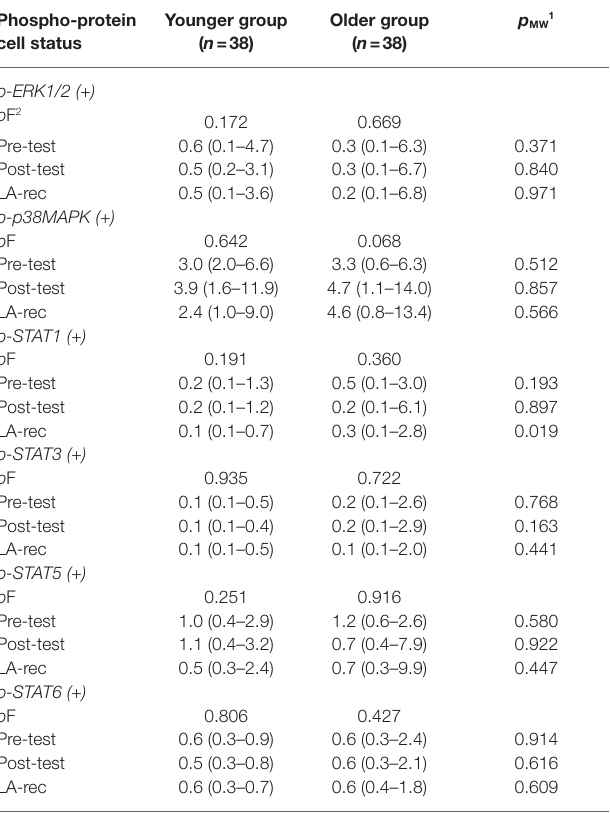
TABLE 4 | Percentage of T helper (CD4+) cells expressing (+) the analyzed phospho-proteins in peripheral blood of the participants. Phospho-protein Younger group Older group cell status ( n = 38) ( n =